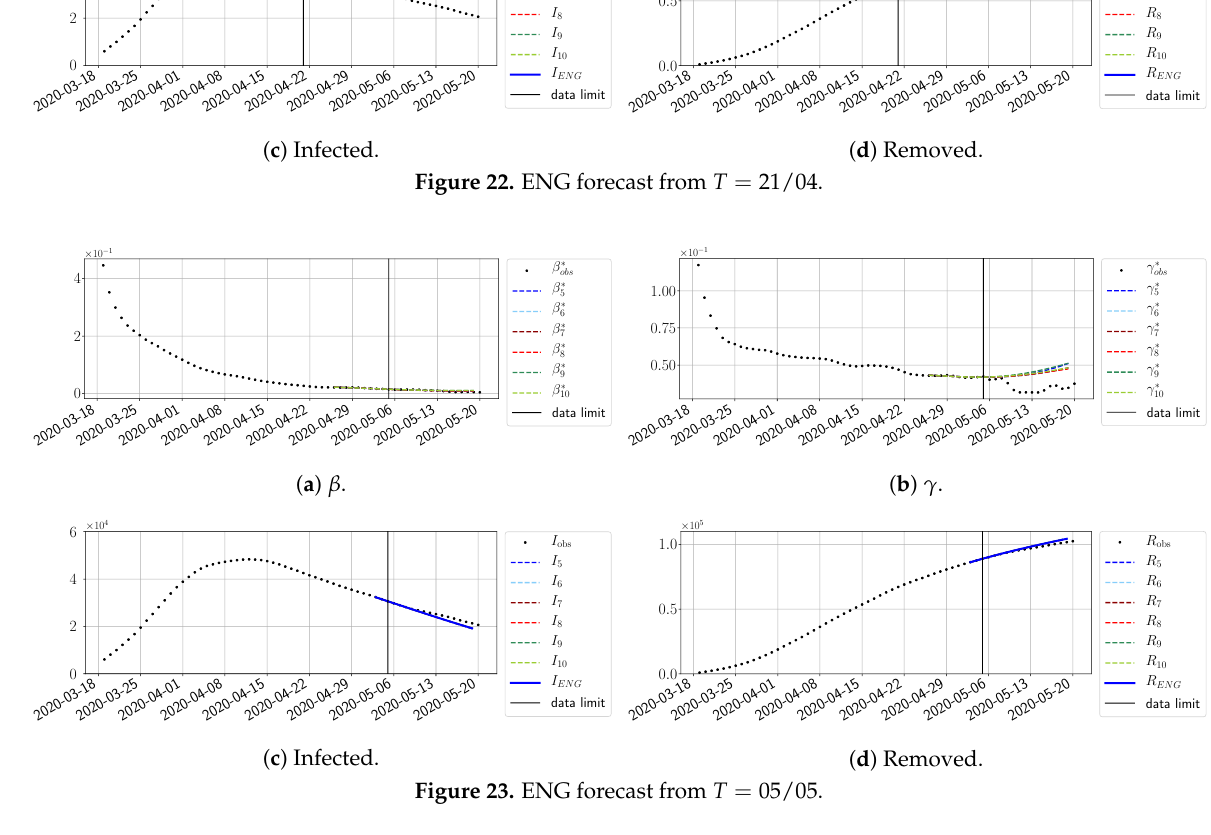
Figure 23. ENG forecast from T = 05/05.